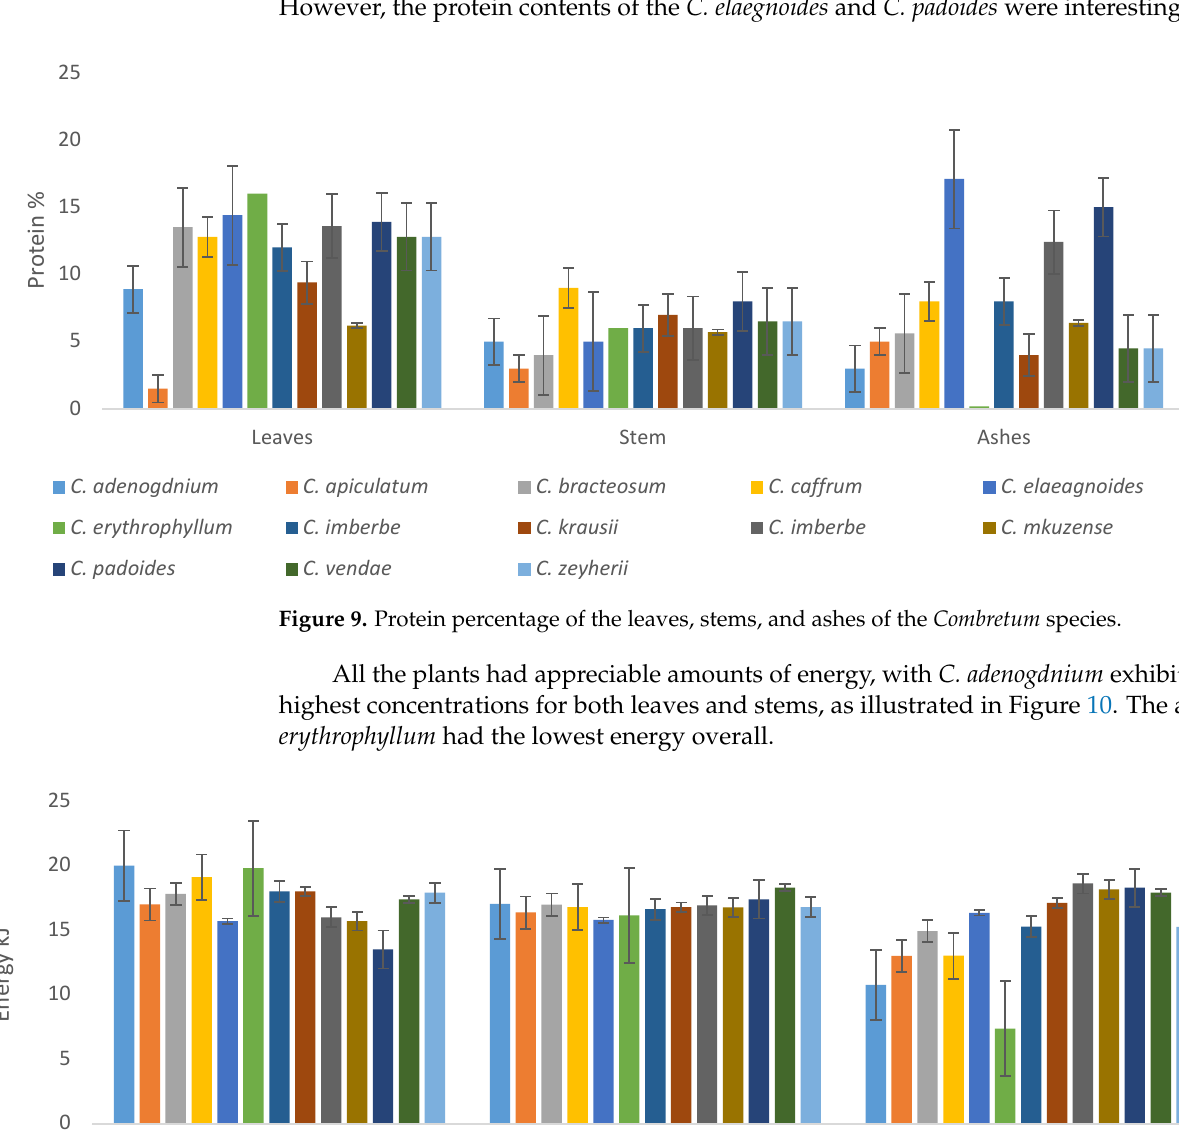
Figure 8. Moisture content (%) of the leaves and stems of the Combretum plants.